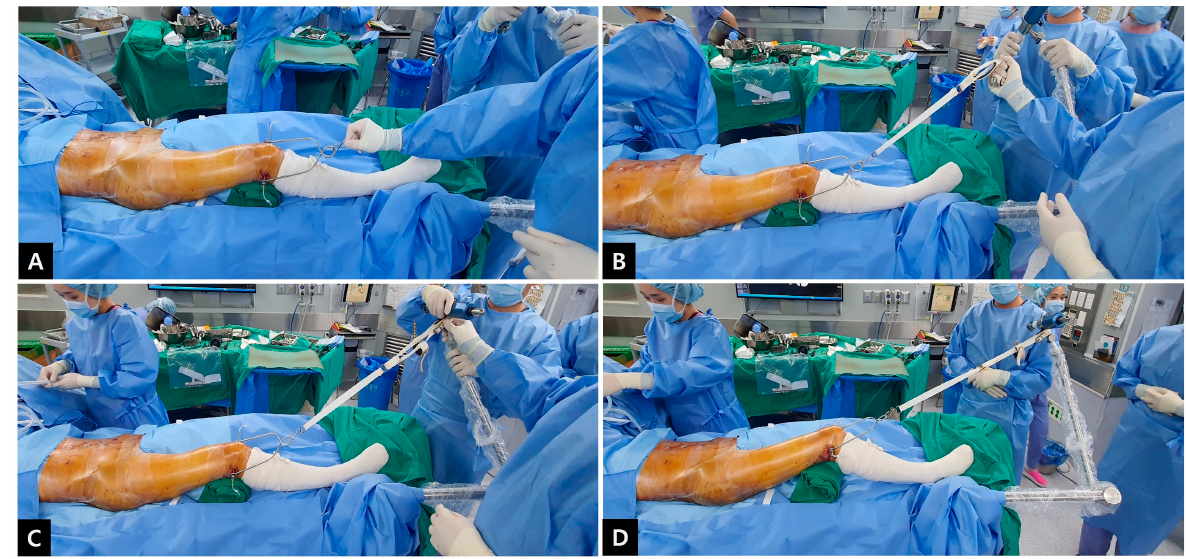
Figure 2. After transfixing the Steinmann pin in the distal femur, it was connected with a traction stirrup ( A ). The Stein ‐ mann pin ‐ traction stirrup construct was affixed to the limb positioner ( B ). Sufficient manual traction force was applied through the stirrup ( C ). The limb positioner was locked while maintaining traction ( D ).